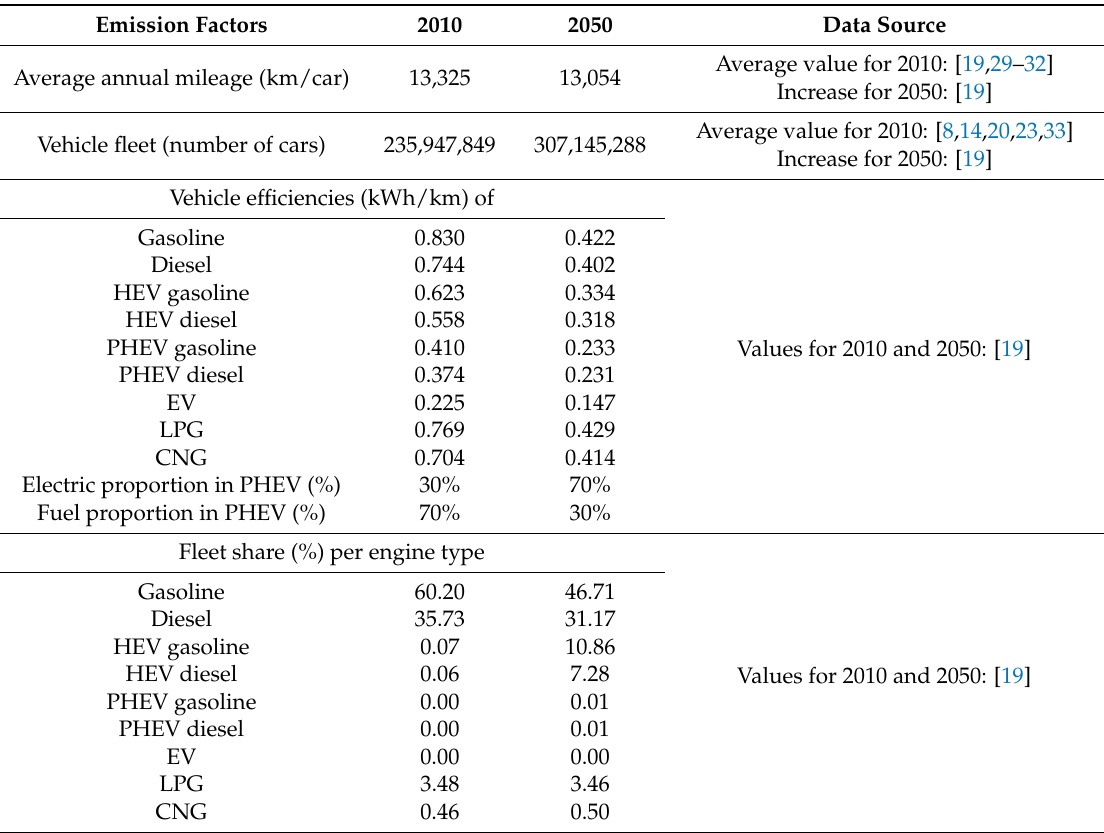
Table A1. Data sources for baseline and